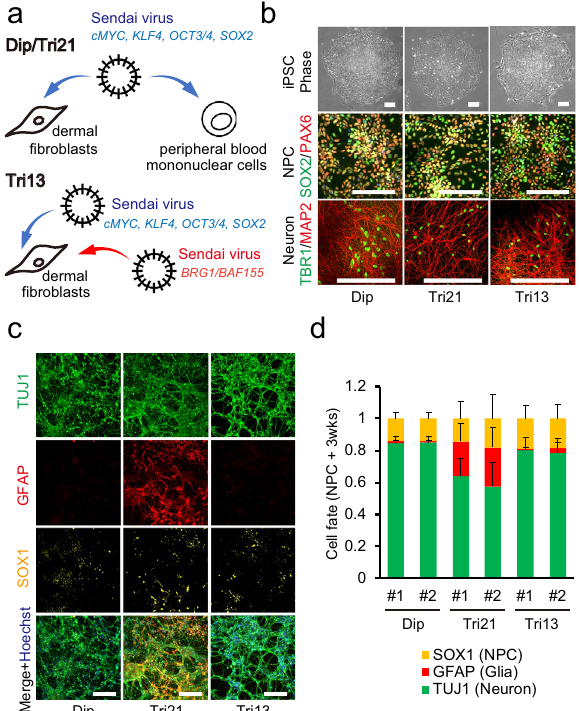
Figure 1. Establishment of trisomy-specific iPSCs and early enhanced gliogenesis in trisomy 21 NPCs. ( a ) Schematic diagram showing the reprogramming processes of diploid control, trisomy 21, and trisomy 13 iPSCs. ( b ) iPSCs generated from diploid, trisomy 21, and trisomy 13 patients showed ESC-like morphology (phase image). NPCs differentiated from iPSCs expressed the NPC markers SOX2 and PAX6. Neurons differentiated from NPCs after 3 months expressed the pan-neural marker MAP2 and cortical neural marker TBR1. Scale bar = 200 μm. ( c ) Representative image of immunocytochemistry for a neural marker (TUJ1), glial marker (GFAP), and NPC marker (SOX1) after 3 weeks of differentiation from NPCs. Scale bar = 200 μm. ( d ) Quantification of the ratio of each marker-positive cell/Hoechst 33342-positive cell after 3 weeks of differentiation from NPCs. Data are presented as mean ± SEM. n = 3 per